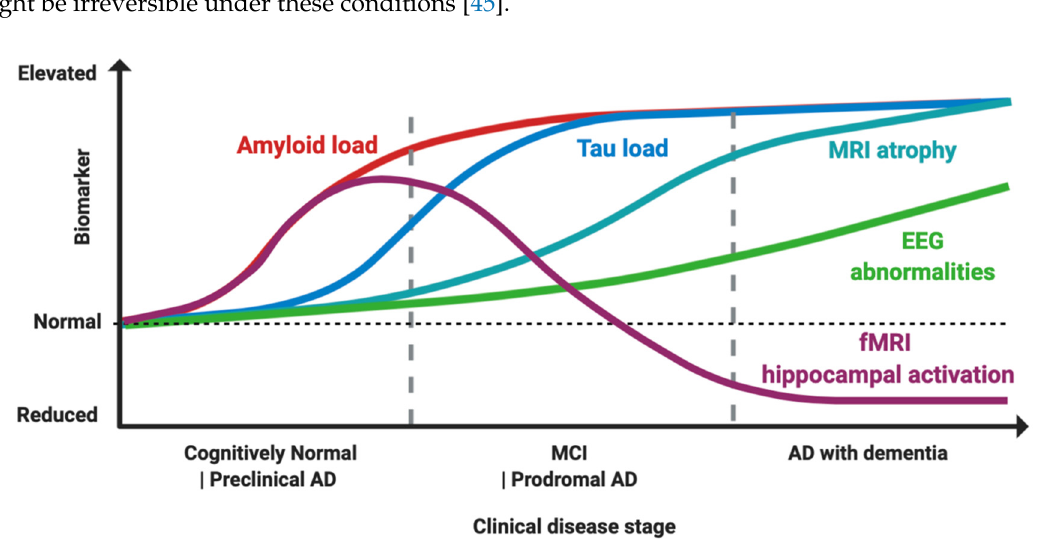
Figure 1. Proposed model of biomarker dynamics of hyperexcitability in humans. Amyloid load, measured by either cerebrospinal fluid (CSF) or Pittsburgh B compound amyloid ligand (PiB) positron emission tomography (PET), is the first to increase. Functional magnetic resonance imaging (fMRI) hippocampal activation is elevated in the preclinical and early prodromal Alzheimer’s disease (AD) phases, and subsequently decreases, with final hypoactivation in AD dementia stage. Tau load elevation, at CSF analysis or tau imaging, subsequently follows. Higher rates of MRI atrophy appear after fMRI hyperactivation and tau increase. Electroencephalogram (EEG) abnormalities increase longitudinally as disease progress, with suboptimal detection rates. The combined effect of A β amyloid and tau induces hyperexcitability in early and hypoexcitability in late disease stages, as depicted by fMRI hippocampal activation. Made in ©BioRender-biorender.com.